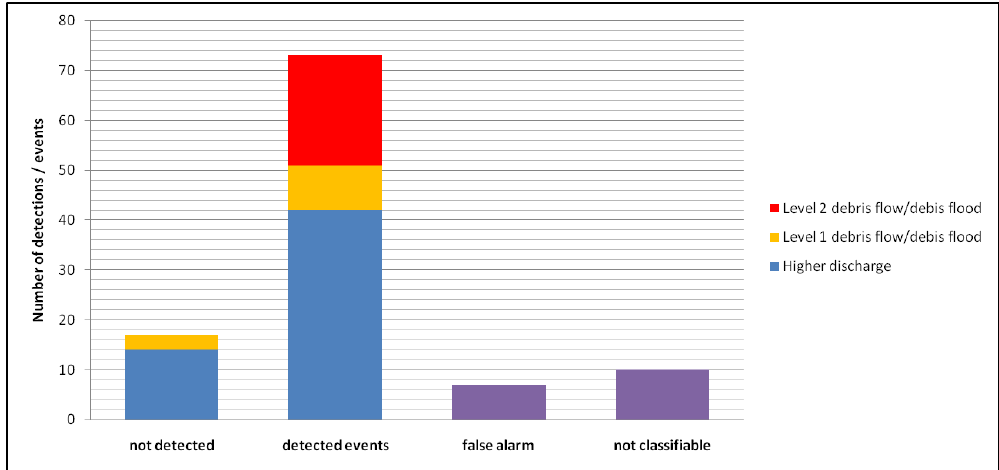
Figure 9. Summary of event detections and undetected events for all test sites from 2013 to